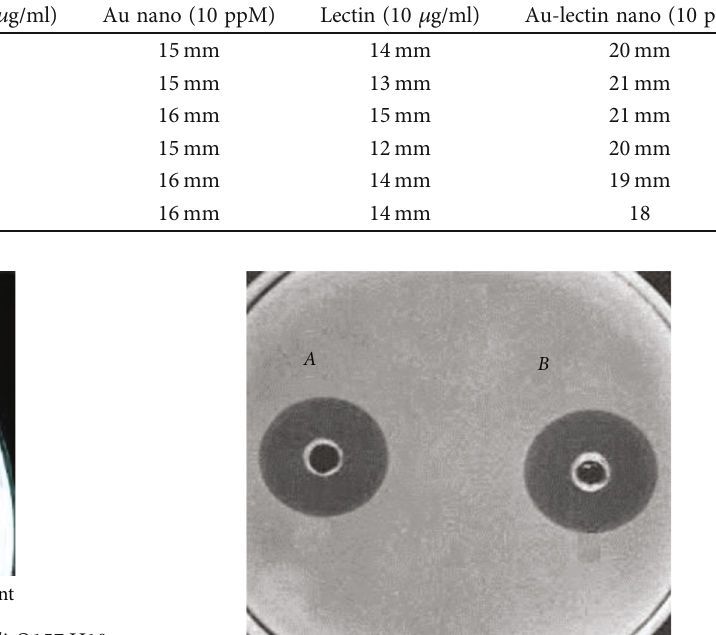
Figure 4: The diameter of inhibition zone for E. Coli O157:H10. Zone of inhibition against tested pathogen suggests that nanoparticle-treated-killed bacteria are reservoirs of these particles.